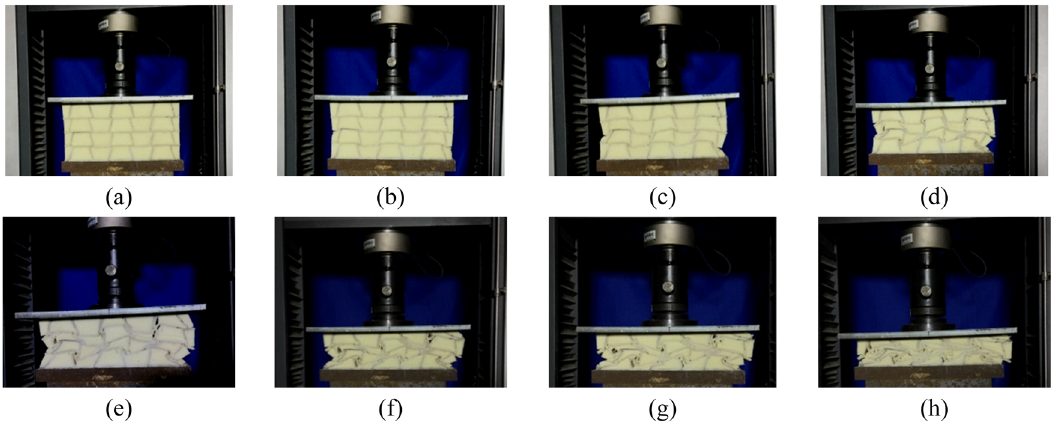
Figure 8: Quasi - static experiment of TS - T - A75: ( a ) beginning, ( b ) Δ = 15 mm, ( c ) Δ = 30 mm, ( d ) Δ = 45 mm, ( e ) Δ = 60 mm, ( f ) Δ = 75 mm, ( g ) Δ = 90 mm, ( h ) Δ = 105 mm.